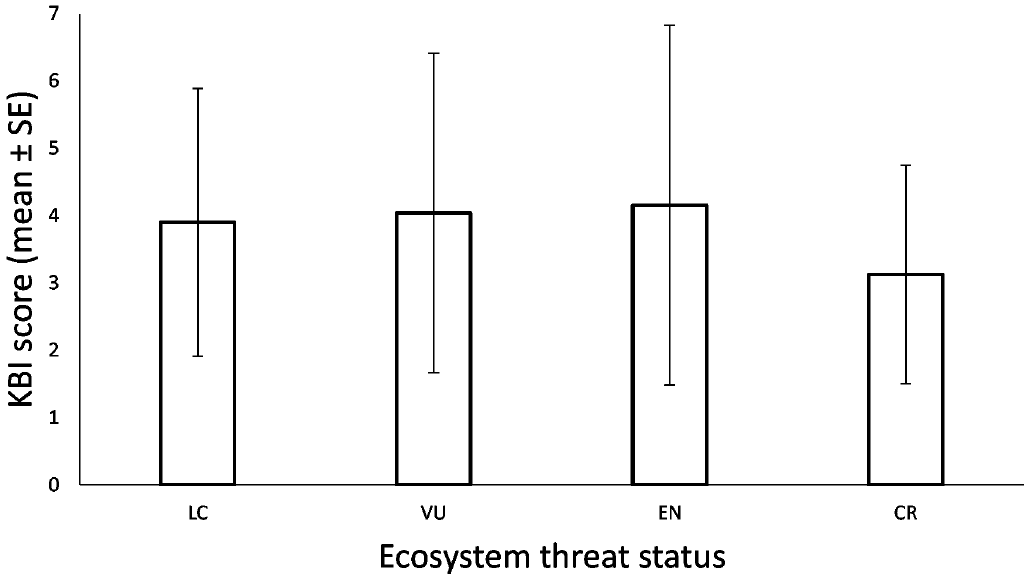
Figure 4. Distribution of Katydid Biotic Index (KBI) among ecosystem threat statuses (mean ± s.e.).